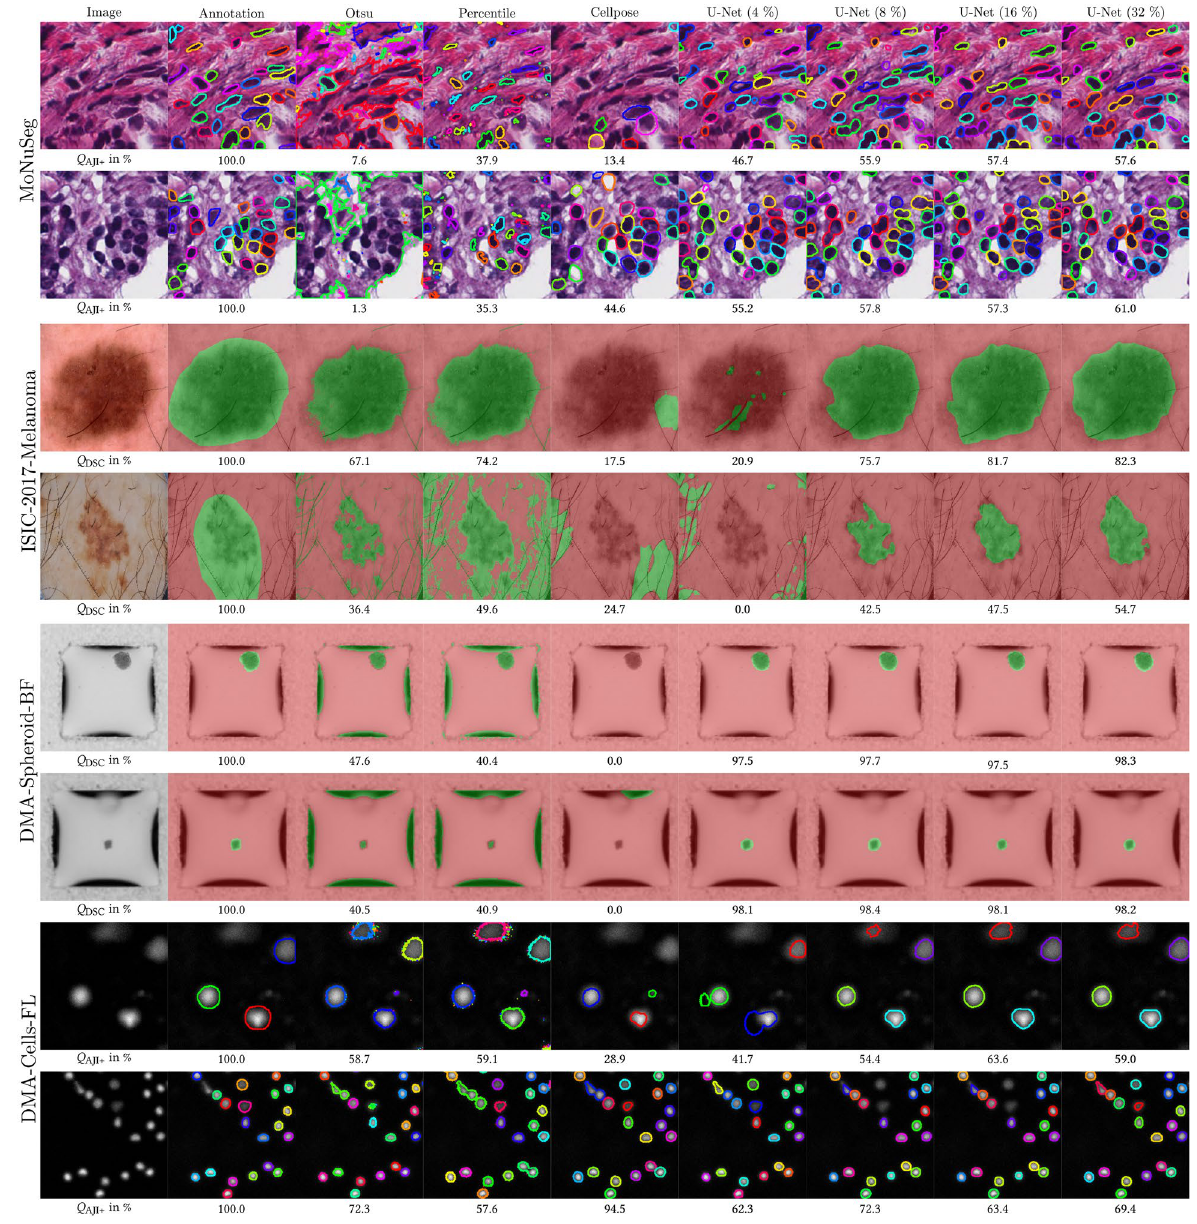
Figure 10. Pre-Annotation. The results of different pre-annotation methods (Otsu, percentile threshold, Cellpose 39 , U-Net 40 ) are shown. Example images (first column) of the data introduced in Fig. 2 are illustrated compared to the annotation (second column). Only the U-Net has been trained on an already annotated sub-dataset. Here, 4% to 32% of all images in the dataset were annotated in advance. The other methods do not require an annotated sub-dataset. In addition to qualitative results in the form of contours or overlays, quantitative metrics (Dice Coefficient Q DSC or advanced Aggregated Jaccard Index Q AJI+ ) are displayed in Fig. 10, where two examples per dataset, including the original annotation, are shown compared to different pre-annotation methods. In addition, the performance of methods per image is qualitatively shown using overlay/contour and quantitatively by metrics (Dice Coefficient Q DSC / advanced Aggregated Jaccard Index Q AJI+ ). The core message of the evaluation is that the suitability of the particular method for pre-annotation depends on the problem/dataset. Therefore, as suggested in the concept, it is helpful to be able to select different methods based on the problem. In this context, a DNN (here: U-Net 40 ) trained on a small dataset is a generic method. However, the method has the disadvantage of requiring an already annotated dataset for training. Moreover, the trend shows that the prediction accuracy improves when a more extensive set of annotations is available for the initial training of the DNN. However, the results do not show a monotonic progression of the learning curve, i.e., the performance as a function of the annotation rate, for all datasets. To sum up, the amount